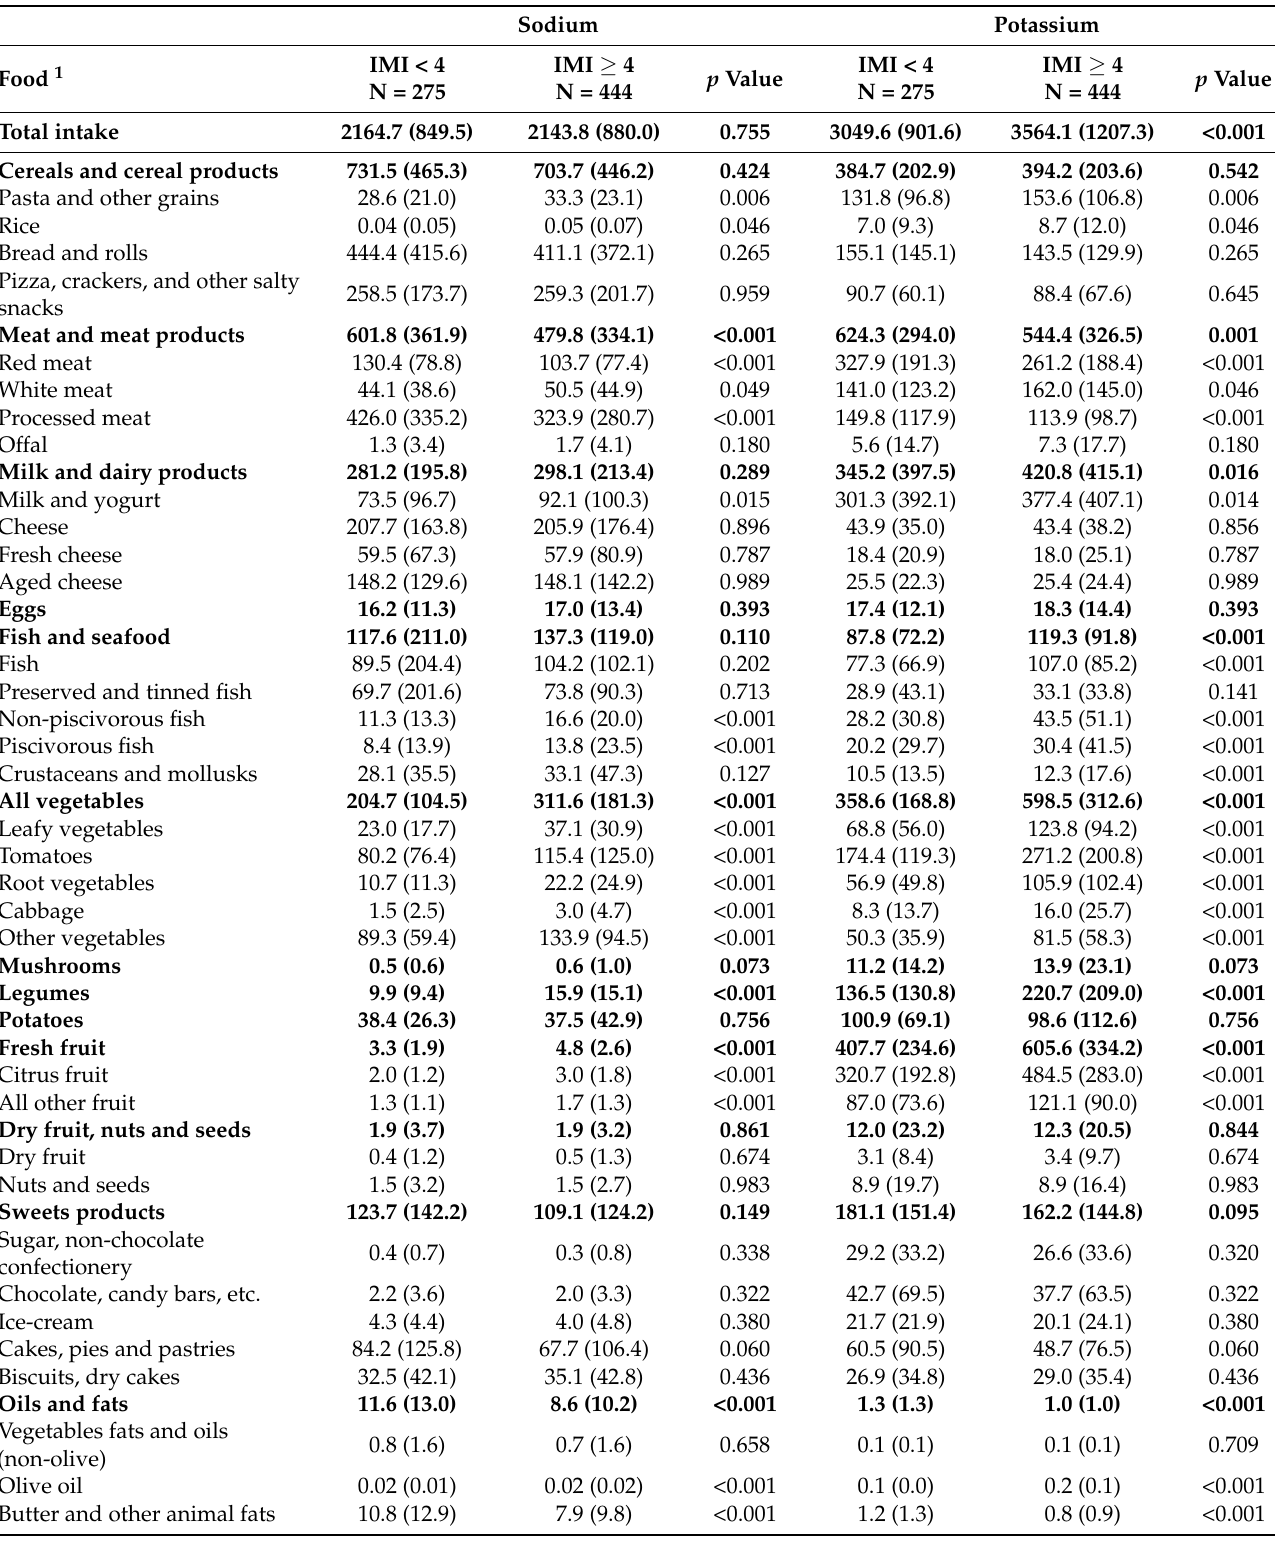
Table 5. Distribution of sodium and potassium daily dietary intake below (<4) and above ( ≥ 4) the median adherence to the Italian Mediterranean Index (IMI) (in mg/day). Mean, standard deviation and p values form the t -test of difference between means are